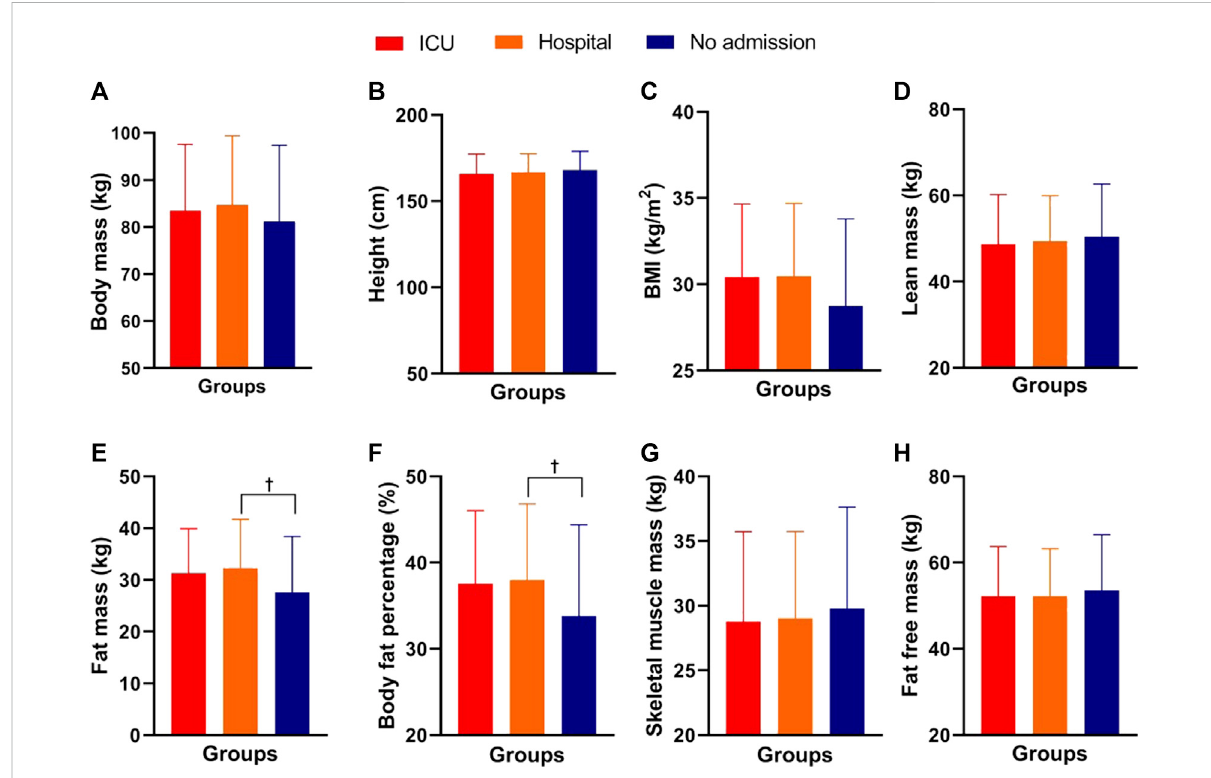
FIGURE 1 Morphological parameters of male and female COVID-19 survivors in the ICU, hospitalized, and non-hospitalized groups. Note: data are presented as the mean and (±) standard deviation; Panel (A) = body mass; Panel (B) = height; Panel (C) = body mass index; Panel (D) = lean mass; Panel (E) = fat mass; Panel (F) = body fat percentage; Panel (G) = musculoskeletal mass; Panel (H) = fat-free mass; † = COVID-19 hospitalized group had signi fi cantly higher values than the non-hospitalized COVID-19 group. One-way ANOVA with Bonferroni post hoc test. Level of signi fi cance established = p <